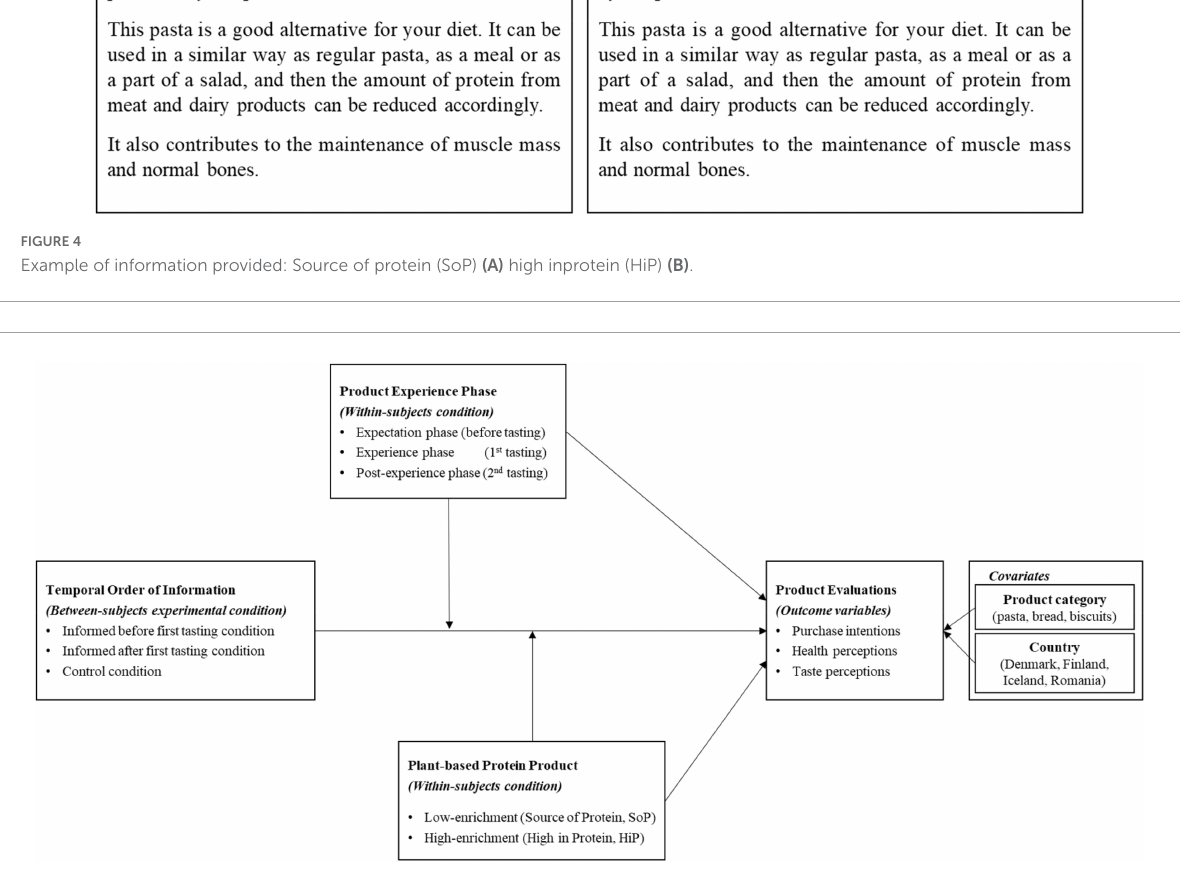
FIGURE5 Design of repeated measures